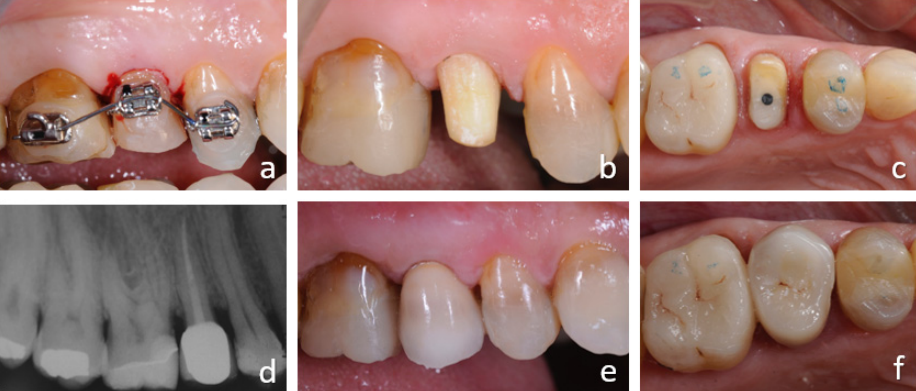
Figure 2. Orthodontic extrusion of 1.5 with insufficient ferrule effect. Orthodontic therapy to extrude tooth 1.5 ( a ). Tooth preparation after orthodontic extrusion: buccal and vestibular views ( b , c ). Prosthetic rehabilitation: post-operative radiograph and buccal and occlusal views ( d – f ).